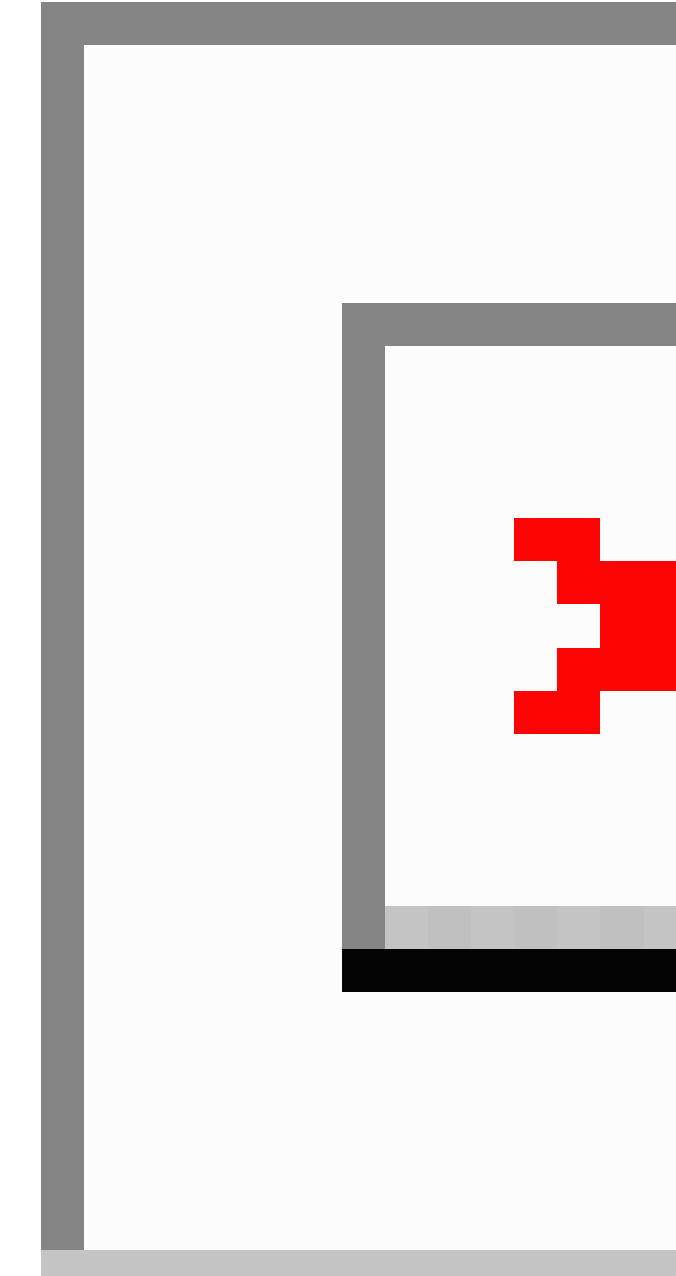
Figure 2. Flowchart of analysis stages with corresponding sample